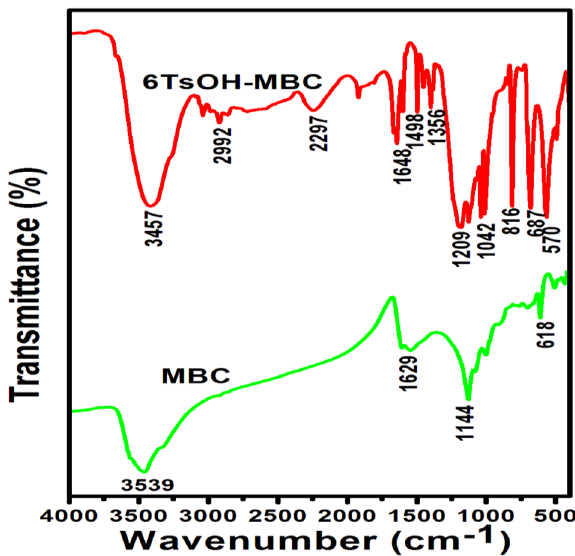
Figure 3. FTIR spectra of MCB and 6TsOH-MBC catalyst.